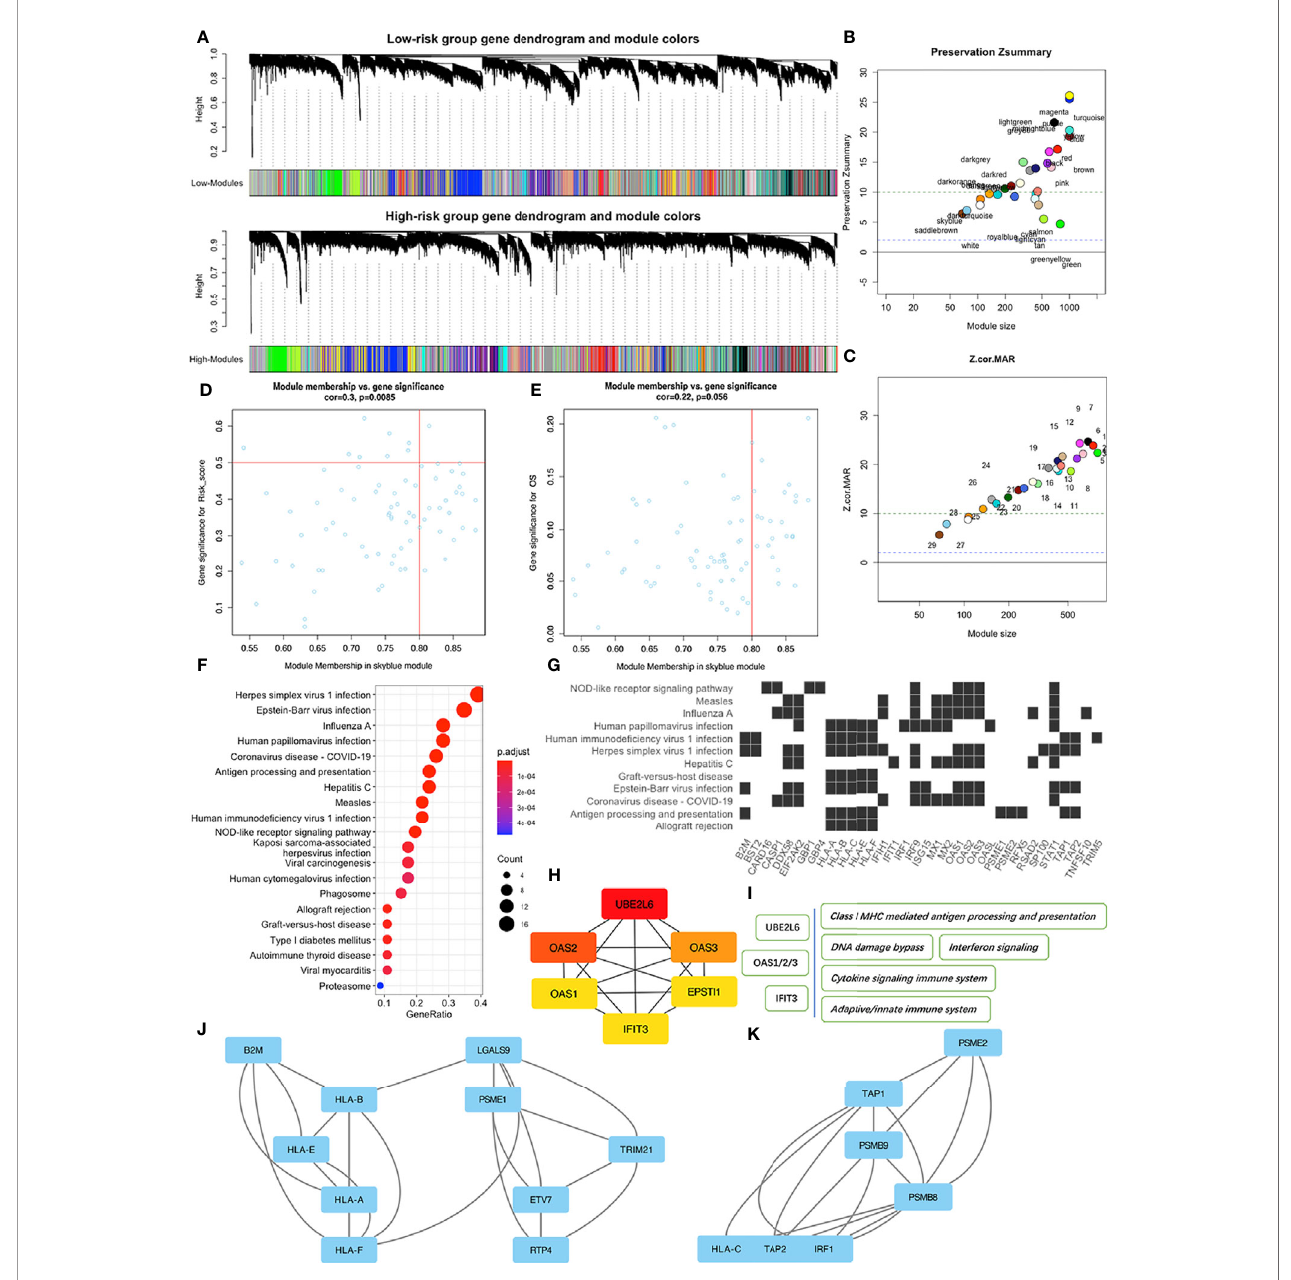
FIGURE 5 | WGCNA of patients in the high and low risk-score subgroups in the TCGA-PAAD dataset. (A) Dendrograms of high and low risk-score subgroups. (B) The Preservation Zsummary of co-expression modules. (C) The Preservation Z-Statistics of co-expression modules. (D) Scatter plot for the module membership vs. gene signi fi cance for risk-scores in the skyblue module. (E) Scatter plot for module membership vs. gene signi fi cance for OS in the skyblue module. (F) Functional enrichment analysis of skyblue module genes for KEGG pathways. (G) Distribution of some skyblue module genes involved in speci fi c links in the enriched KEGG pathways. (H) The six hub genes of skyblue module identi fi ed by cytoHubba. (I) Some pathways associated with the hub genes. (J, K) Two of the three key sub networks of the skyblue